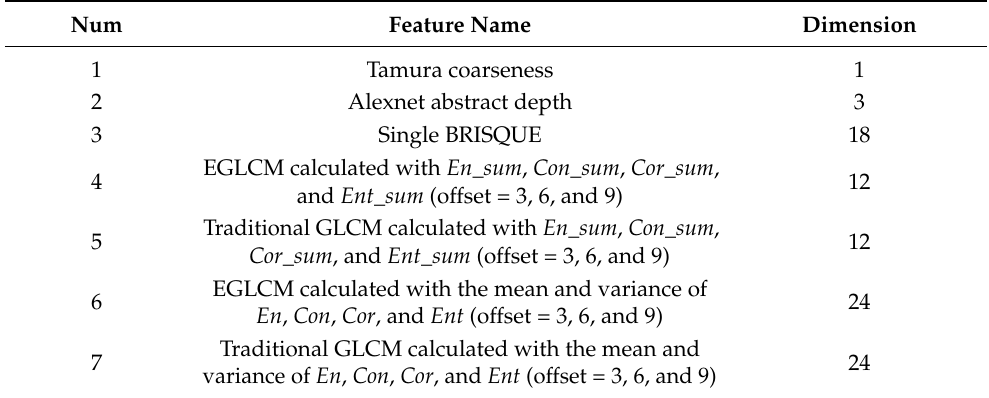
Table 13. The feature names and their dimensions. Num